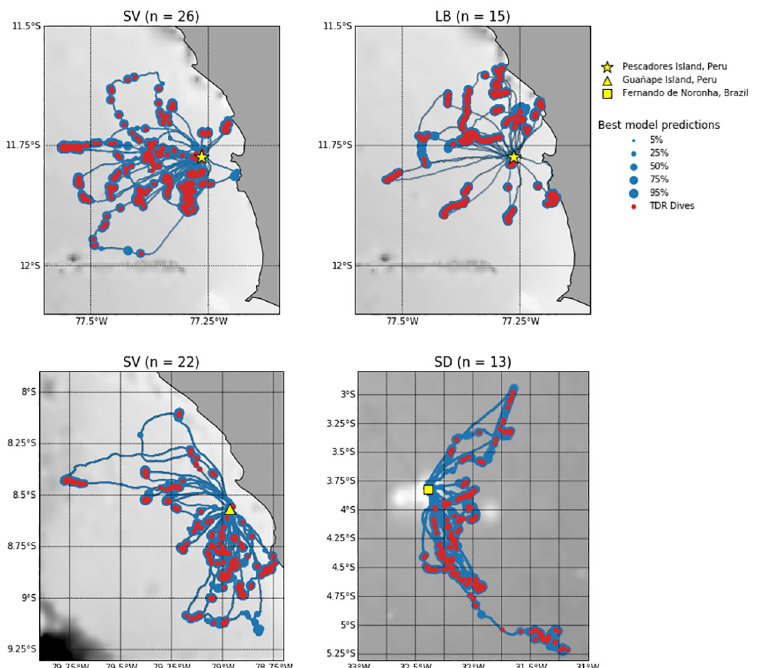
Fig 4. Maps of predicted dives for all ‘test’ datasets. Red points represent true dive derived from TDR data. Blue points represent diving probabilities at each location with radius increasing for higher probabilities. These probabilities are the outputs of the best deep networks for each dataset: Peruvian boobies from Pescadores (top left), and from Gua ñ ape Island (bottom left), Guanay cormorants from Pescadores Island (top right), and masked boobies from Fernando de Noronha archipelago (bottom right). SV stands for Peruvian boobies ( Sula variegata ), LB for Guanay cormorants ( Leucocarbo bougainvilli ) and SD for masked boobies ( Sula dactylatra ). Bathymetry is shown in grey and is extracted from GEBCO gridded dataset (https://www.gebco.net/). Land-sea mask is extracted from GSHHG data (https://www.soest.hawaii.edu/pwessel/gshhg/).